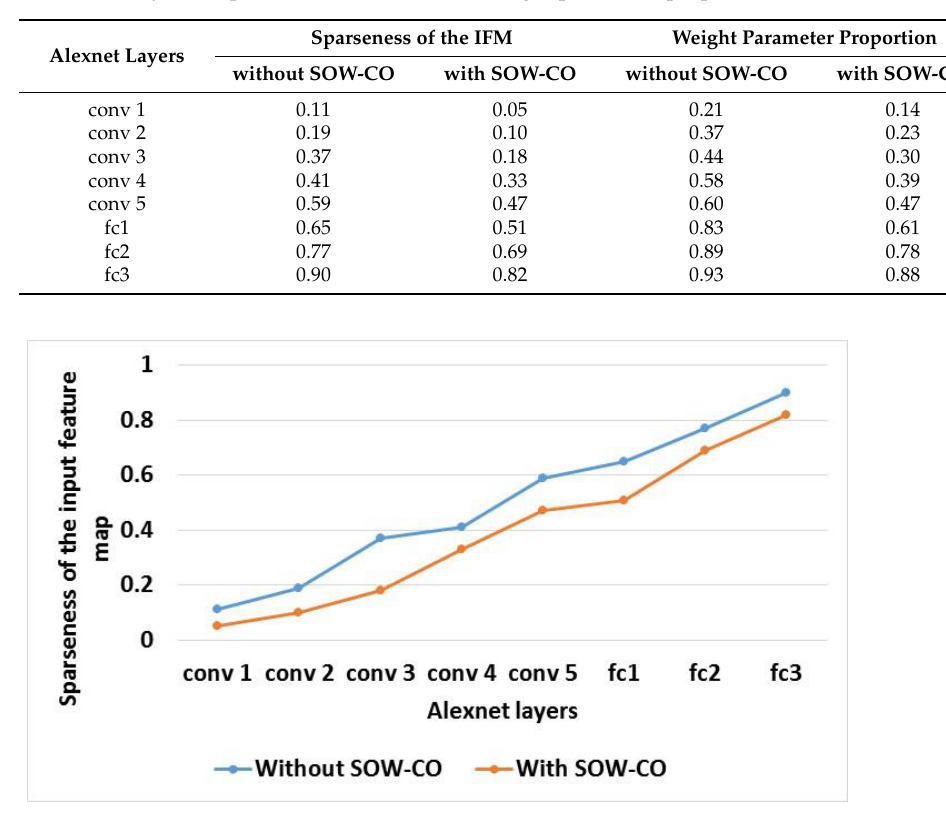
Figure 16. Graphical illustration of weight parameter proportion for Alexnet. Table 6 shows the analysis of sparseness of the IFM and weight parameter proportion for RCNN-VGG16 with and without SOW-CO. Additionally, the comparison of feature map size and weight size for IFM’s sparseness and weight parameter proportion are shown in Figures 17 and 18, respectively. This analysis shows that the IF M’s sparseness and weight parameter proportion of the RCNN with SOW-CO are less when compared to the RCNN without SOW- CO. The IFM’s sparseness and weight parameter proportion are increased because of the CNN without any convolutional and weight optimization.